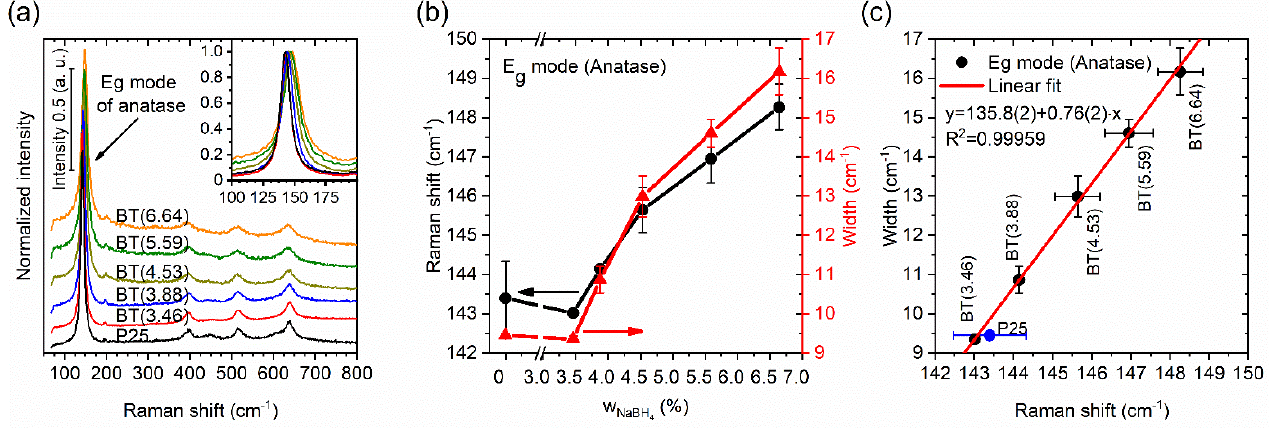
Figure 3. ( a ) Raman spectra of the samples, inset: magnification of the E g mode. ( b ) Raman shift and width of the E g mode as function of the amount of reducing agent used. ( c ) Relationship between Raman width and shift of the E g mode.